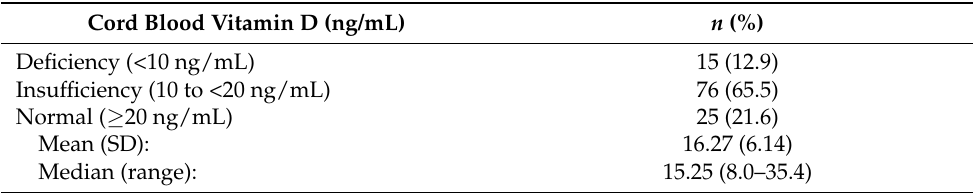
Table 2. Cord blood vitamin D in newborns.